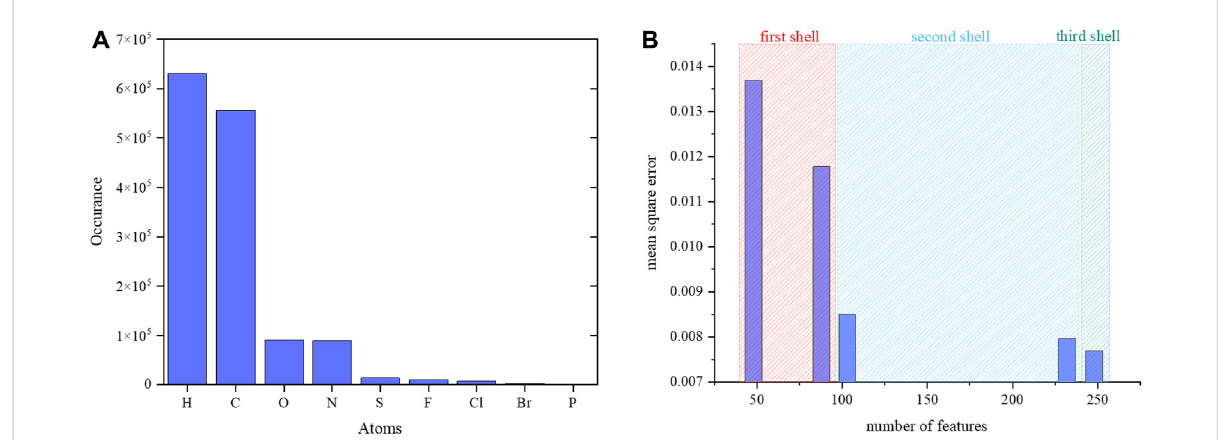
FIGURE 6 (A) Number of samples per element in the data set. Numbers for phosphorous atoms are not visible in the graph as very few phosphorus atoms were present in the data. (B) The calculated MSE vs. number of atomic features for a reference